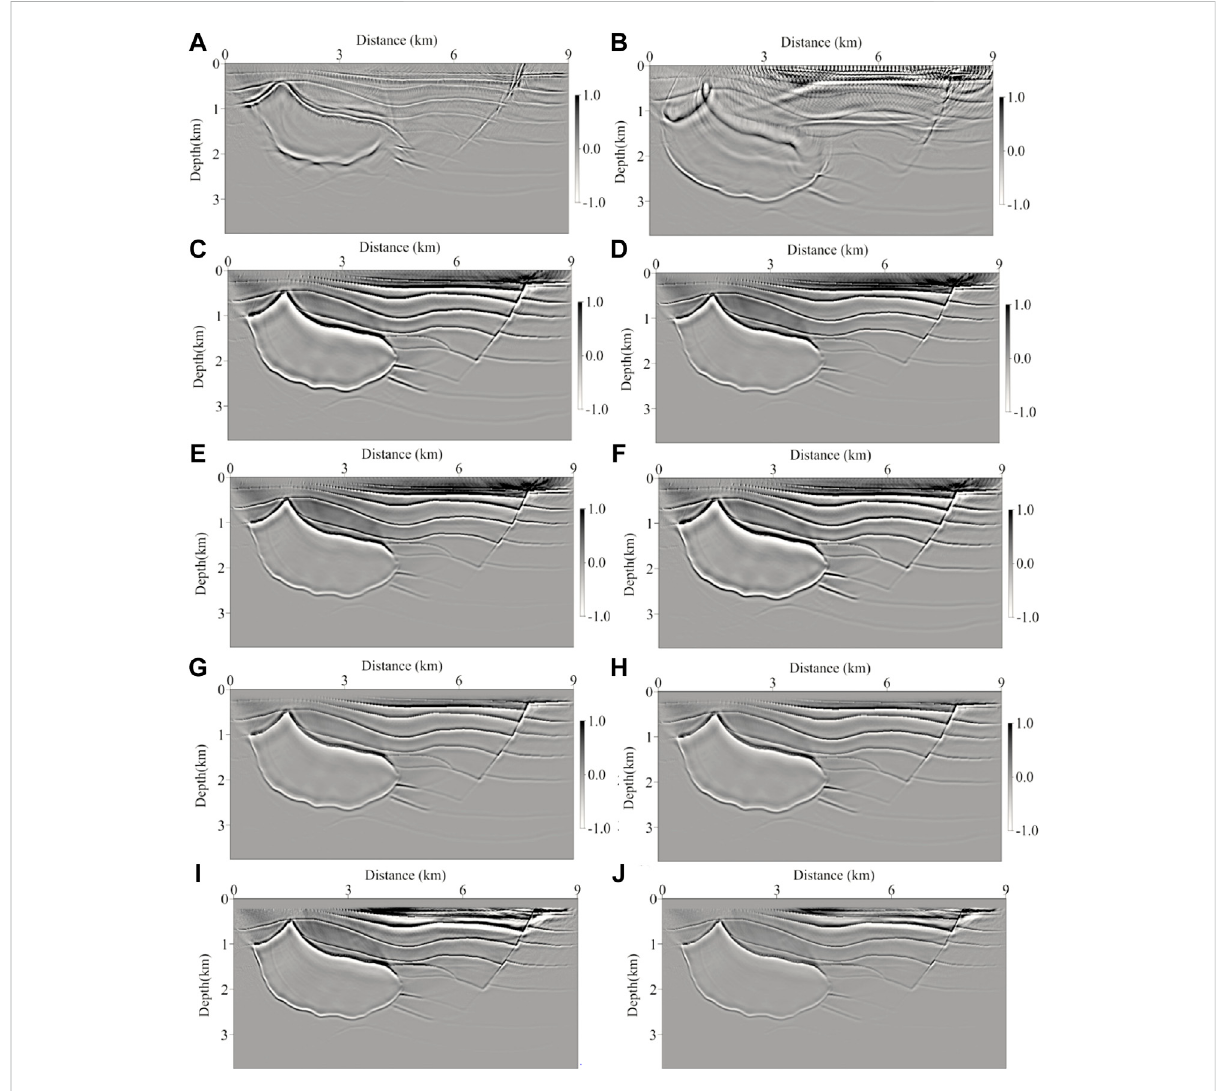
Error analysis of the LSRTM parameters for the Hess model. (A) 10% decrease in velocity, (B) 10% increase in velocity, (C) 10% decrease in ϵ , (D) 10%increasein ϵ , (E) 10%decreasein δ , (F) 10%increasein δ , (G) 10%decreasein Q ,and (H) 10%increasein Q , (I) 30 ° phaserotationofwavelet, (J) 90 ° phase rotation of wavelet. And the color scales of all the images are the